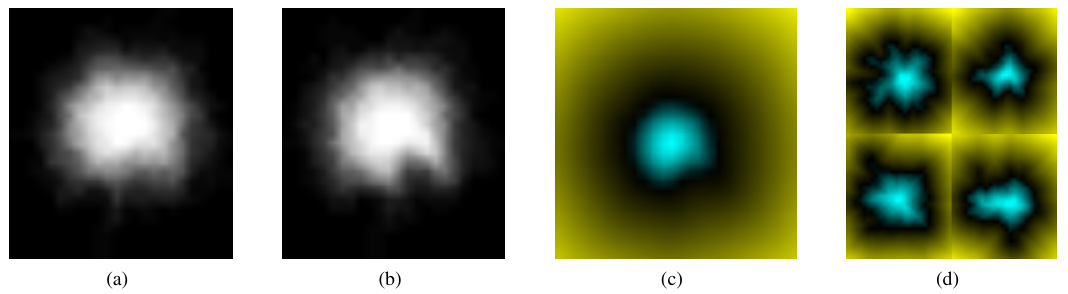
Figure 2. Deriving the eigenshape representation. (a), (b): mean polygon masks formed by summing all pixel values at corresponding locations in training polygons before and after alignment, respectively. (c): the mean signed distance function (SDF) of the training set. (d) SDFs of sample training shapes represented using 20 first eigenmodes of shape variation. In (c)-(d), the cyan and yellow colors represent the interior and exterior of the shape, respectively, with intensity proportional to the distance from the shape